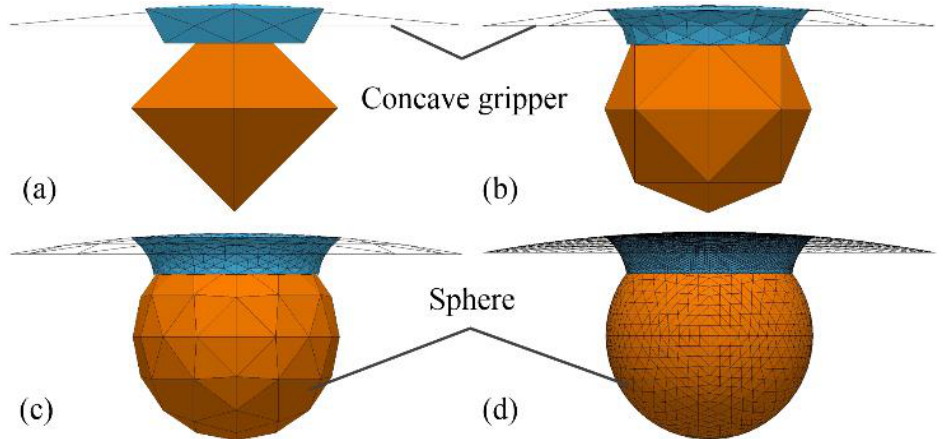
Figure 7. Evolution processes of the capillary bridge: ( a ) initial definition, ( b , c ) evolution pro- cesses, and ( d ) after evolution.